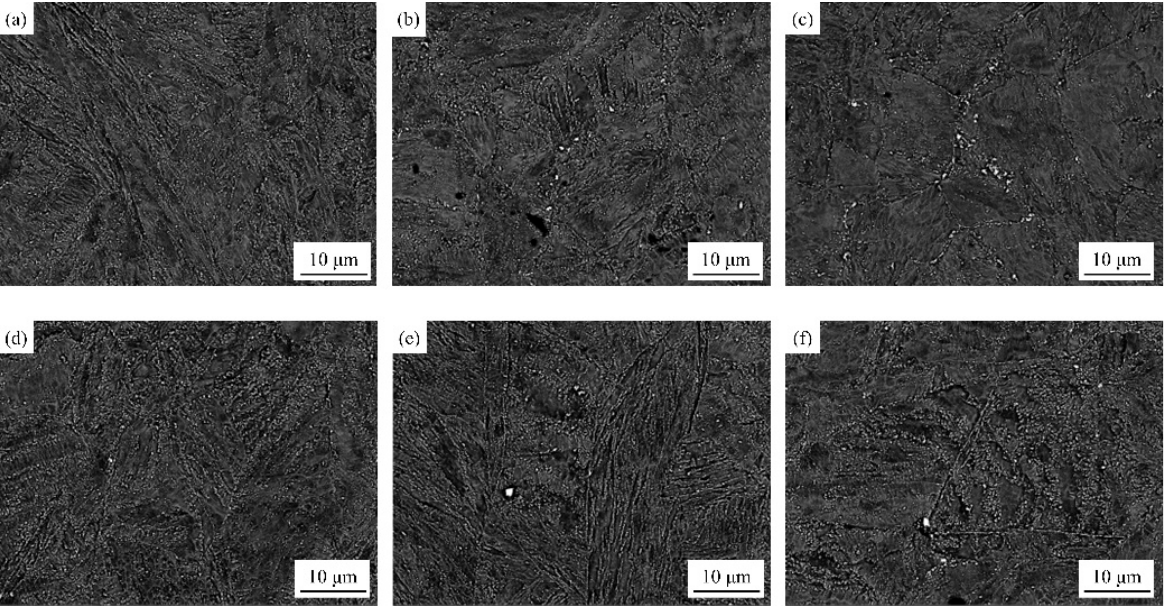
Figure 11. BSE images of 0.004ZrD ( a – c ) and 0.004ZrH ( d – f ) aged for different times ( a , d ) 500 h, ( b , e ) 1000 h, and ( c , f ) 1500 h.